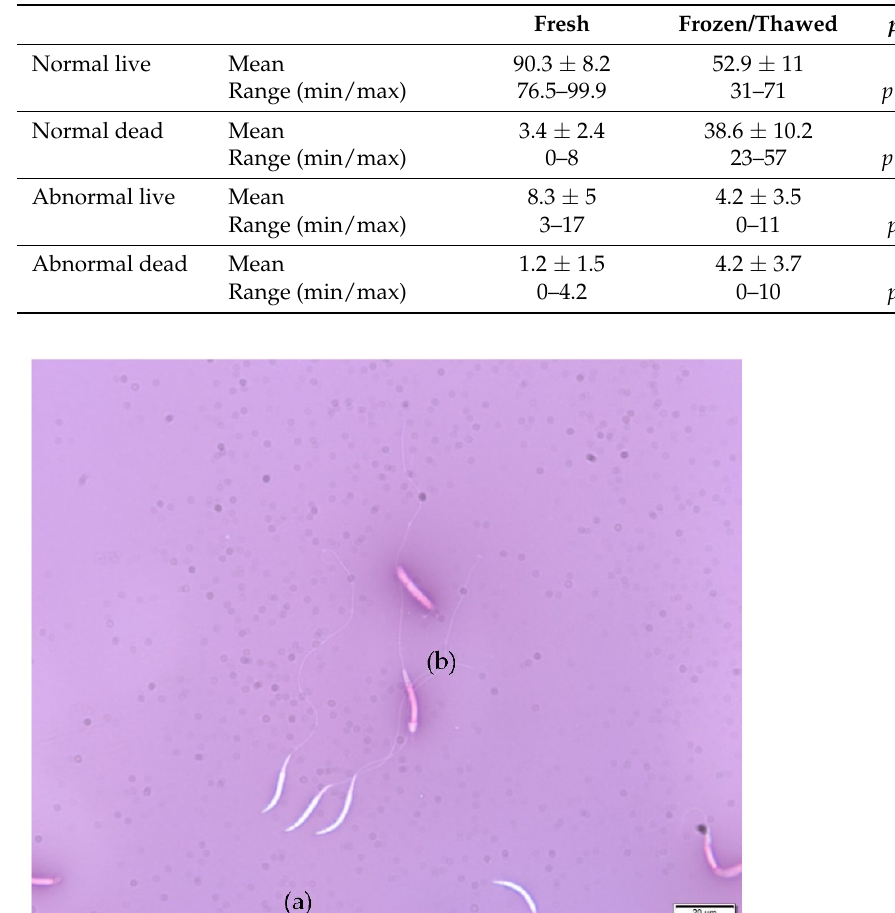
Table 2. Results of sperm viability and morphology analyzes for 13 ejaculates before and after cryopreservation. Means are presented along with standard deviations, and values are presented in percentage.